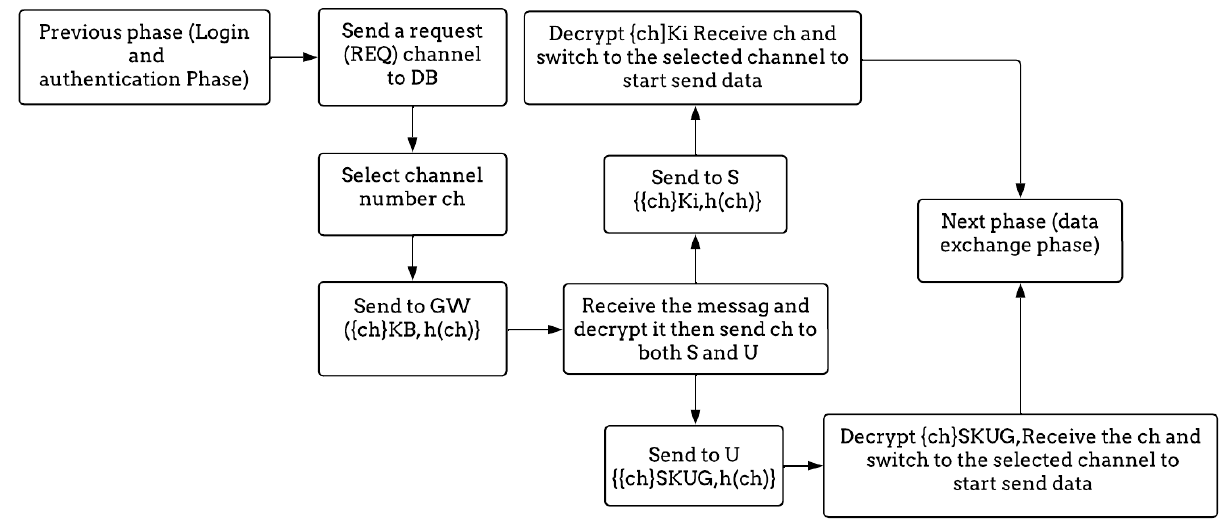
Figure 6. The flow diagram of the control channel exchange phase.